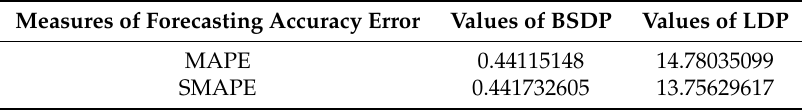
Table 7. Goodness of fit of the two